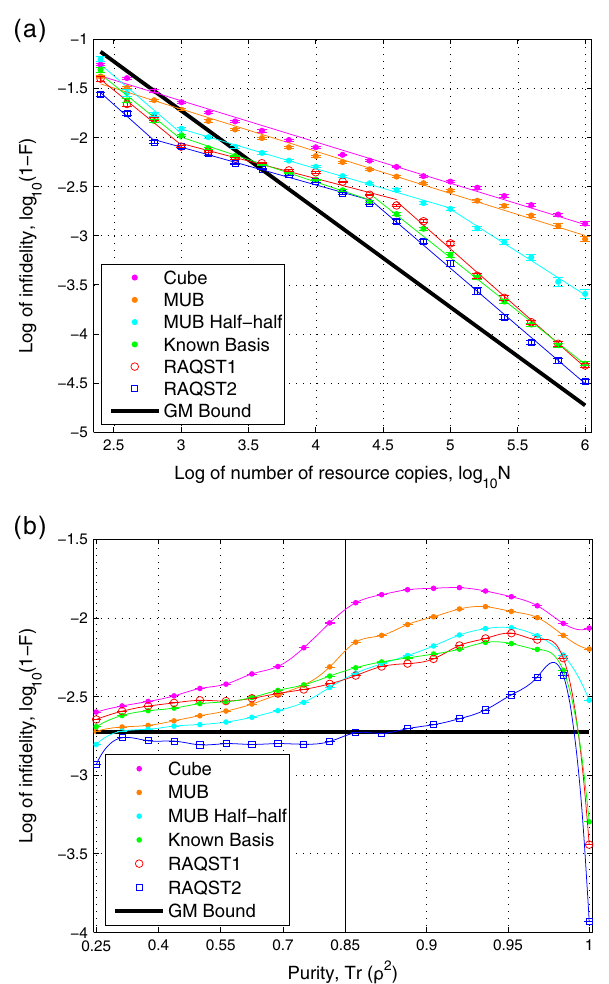
Fig. 2 Performance of the RAQST protocol for mixed states. a In fi delity vs. N with different tomography protocols for state ρ = ρ 2 ) = 0.9955. Each point is averaged ρ W (0.997), which has purity Tr( over 200 realizations. Error bars are the standard deviation of the average. b In fi delity vs. different purity with different tomography methods for Werner states in (5). The total number of copies for each state is N = 10 4 . Each point is averaged over 1000